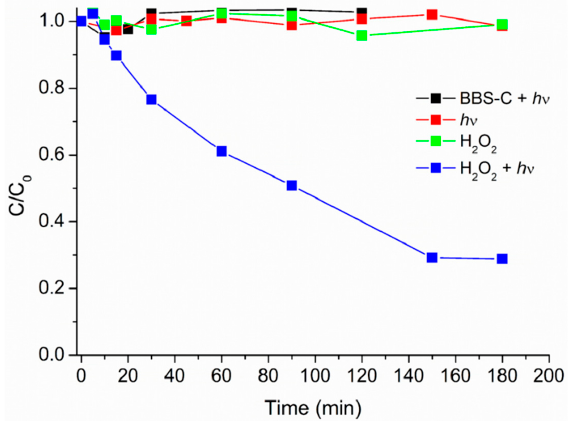
Figure 3. Caffeine concentration (C 0 = 5 mg·L − 1 ) profile in the presence of H 2 O 2 (1.5 × 10 − 3 M) in dark condition (green squares); under irradiation (red squares); in the presence of BBS-C (6 mg·L − 1 ), and under irradiation (black squares); in the presence of H 2 O 2 (1.5 × 10 − 3 M), and under irradiation (blue squares).